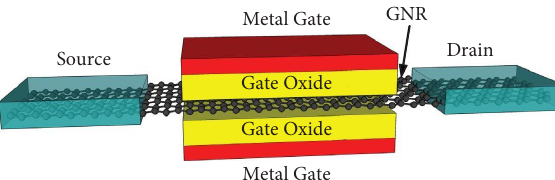
Figure 2: 3D structure of the SB-GNR-FET [19].